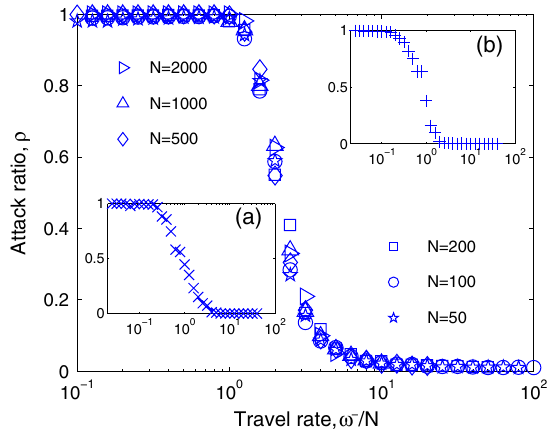
FIG. 3. Results of stochastic simulations. Attack ratio (cid:4) ð ! (cid:1) =N Þ as a function of the return travel rate ! (cid:1) for SIR epidemics on a lattice with 10 2 sites with N agents/site. Epidemic parameters: (cid:1) ¼ 1 , (cid:2) ¼ 0 : 1 . Insets: (a) (cid:4) ð ! (cid:1) =N Þ for a scale-free network ( (cid:6) ¼ 1 : 5 ) of 10 3 nodes populated uniformly with h N i ¼ 250 = site, with k min ¼ 5 and k max ¼ 50 ; (b) (cid:4) ð ! (cid:1) =N Þ for an Erdo˝s-Re´nyi network with 500 nodes and (cid:2) k ¼ 10 . Results were averaged over 50 realizations. Interlocation flux rate was h ! i ¼ 1